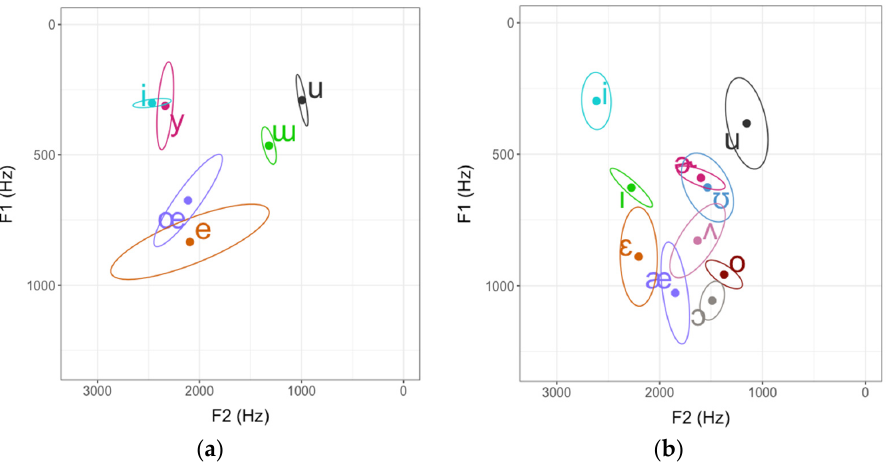
Figure 7. ( a ) Mean F1 and F2 values for L2 Turkish vowels produced by speaker F39. Each ellipse includes approximately 95% of the samples in each vowel category. ( b ) Mean F1 and F2 values for L1 English vowels produced by speaker F39. Each ellipse includes approximately 95% of the samples in each vowel category.